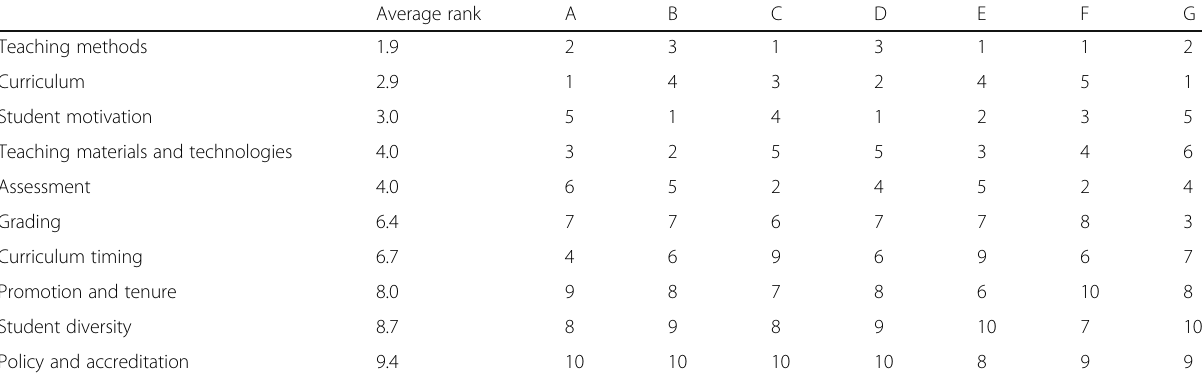
Table 4 Ranking of Euclidean distance of topic networks compared with the all-encompassing networks of each unit Average